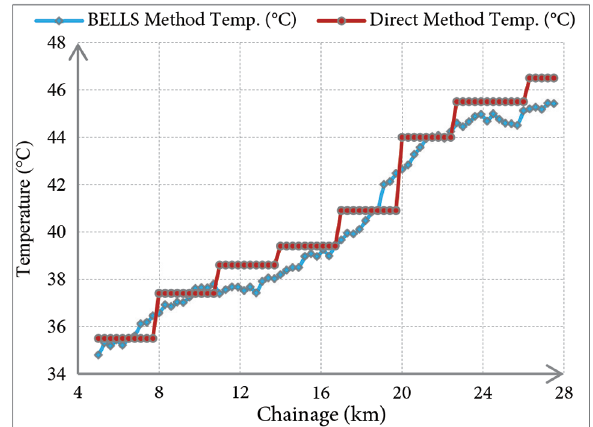
Figure 1. Layer depth temperature determination using BELLS model compared with direct